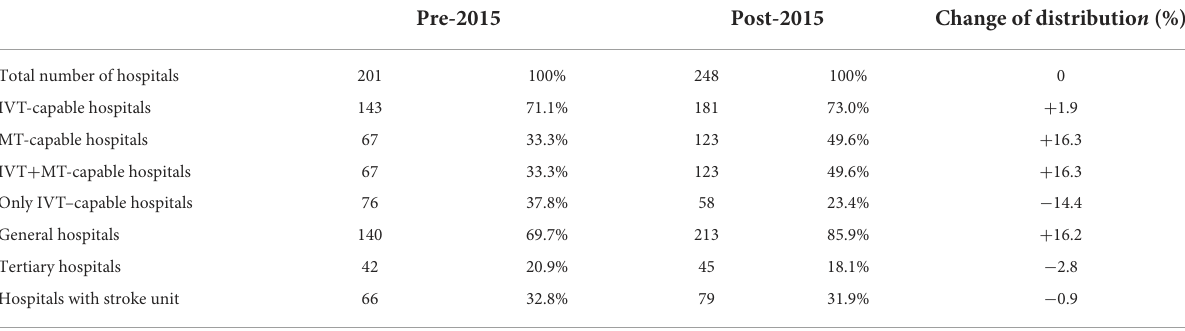
TABLE 3 Change of distribution of IVT- and MT-capable hospitals in pre-2015 and